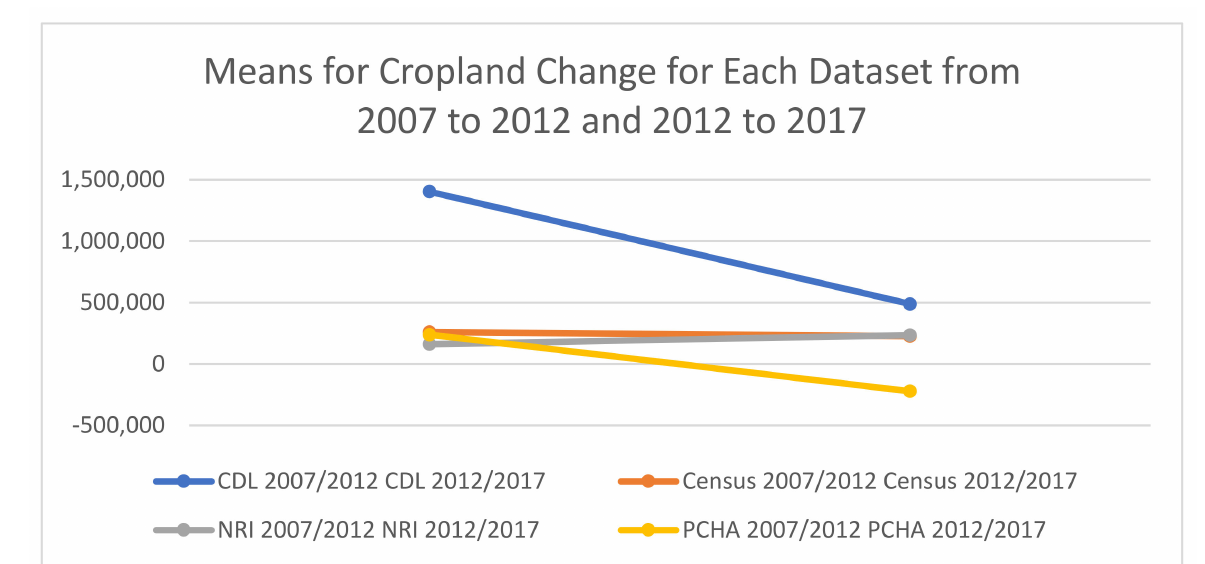
Figure 8. Mean values for cropland change for each dataset from 2007 to 2012 and 2012 to